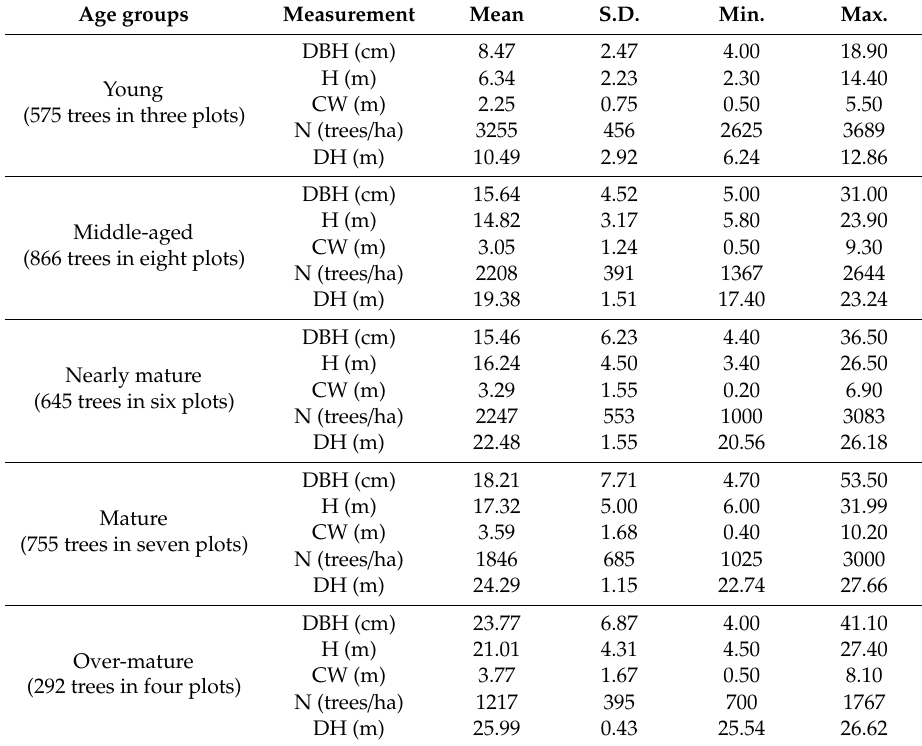
Table 1. Summary statistics of tree and stand variables in plots considered for five distinct age